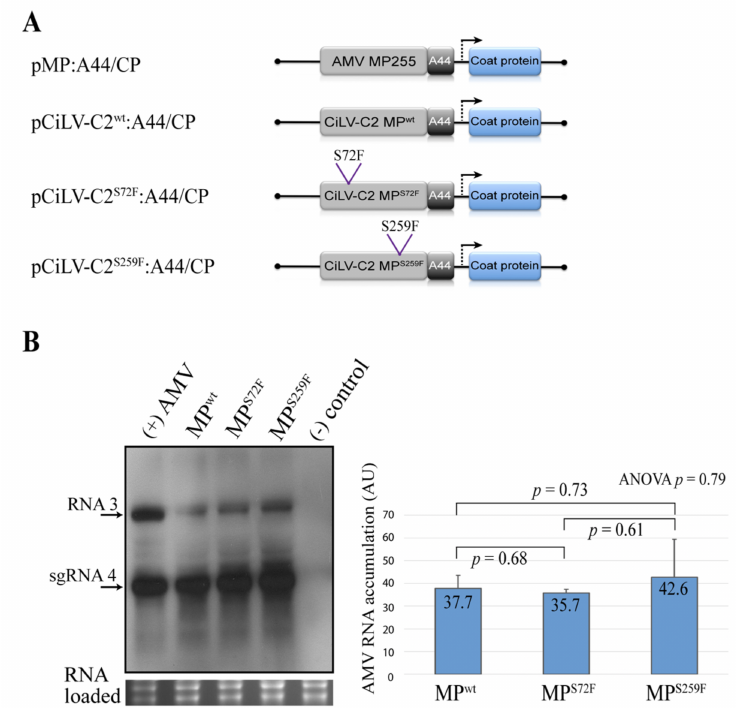
Figure 4. Northern blot analysis of the accumulation of AMV RNA in P12 protoplasts. ( A ) The schematic representation shows the pAL3NcoP3 AMV RNA 3 construct [36], lacking the GFP gene and its derivatives carrying the heterologous CiLV-C2 MPs wild type (WT) and mutated versions (MP S72F and MP S259F ) fused to the C-terminal 44 residues of the AMV MP (A44), used in this assay. ( B ) Northern blot showing accumulation of AMV RNAs in P12 protoplasts at 16 h post-inoculation, using a dig-riboprobe complementary to the 3 (cid:48) UTR of the AMV RNA 3. Transcripts correspond to the AMV RNA 3 derivative carrying the CiLV-C2 MP WT , mutated (MP S72F and MP S259F ) and AMV MP (positive control) proteins. Negative control (-) corresponds to the non-infected P12 protoplasts. The localization of RNA 3 and subgenomic RNAs (sgRNA 4) are indicated. The graph represents the total accumulation of AMV RNA, carrying the constructs CiLV-C2 MP WT , MP S72F , and MP S259F from the average of two independent experiments. The bands were quantified using the ImageJ v. 2.0cr software with the ISAC plugin and error bars represent standard deviation. Statistical analyses were performed using Student’s t -test and one-way ANOVA. Significant differences are interpreted for p values ≤ 0.05. p -values were obtained from pairwise comparisons between treatments or among the three